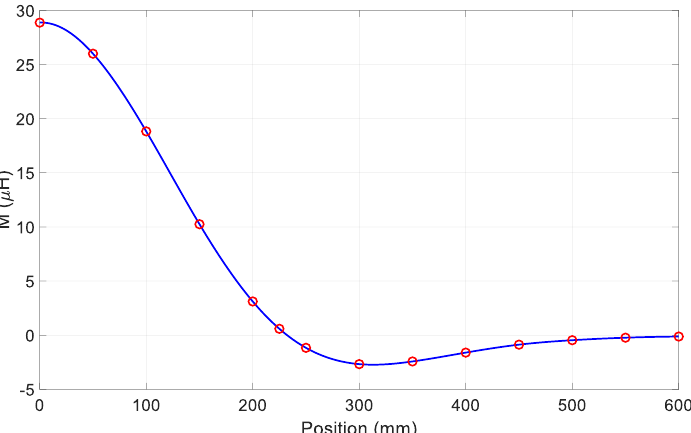
Figure 6. Mutual inductance at different coil positions.